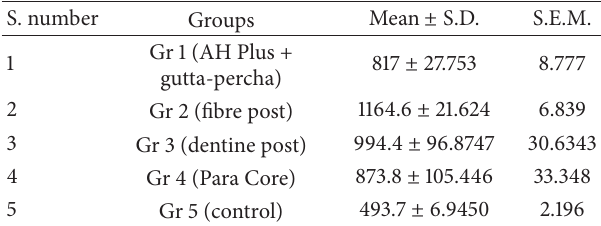
Table 1: Mean and standard deviation and S.E.M. of forces (N) for different groups.